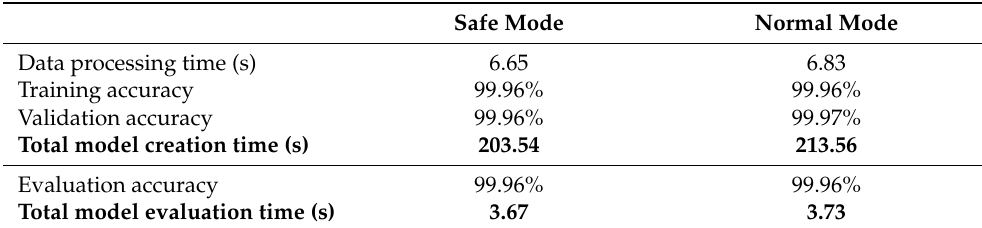
Table 3. Comparison of the averaged measurement results of the ‘PaymentFraud’ dataset for the safe and normal boot mode.